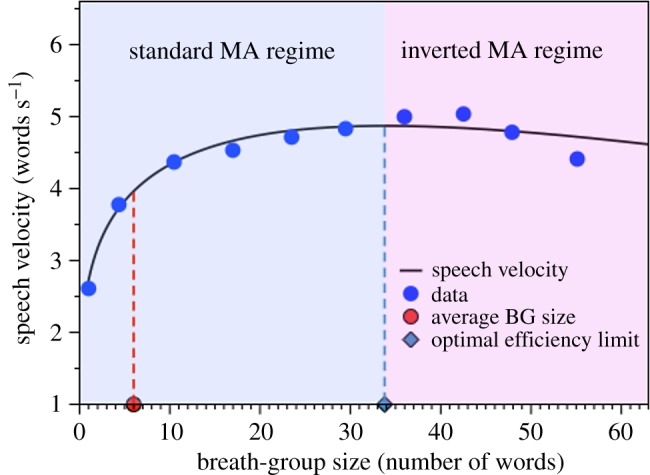
Speech velocity function. When word size is measured in time units, v(n) = 1/y(n), where y(n) is MAL (equation (3.8)) defines the speaker’s speech velocity. This function is in good agreement with empirical data (blue circles) and is maximal for BGs with n* ≈ 34 words. Experimentally, however, we observe BGs with an average size of about 6 words, hence suggesting a suboptimal speech velocity. The critical point n* indeed separates a classical regime n < n* where the standard interpretation of MAL holds, and an inverted regime n > n* where the interpretation of the law switches.